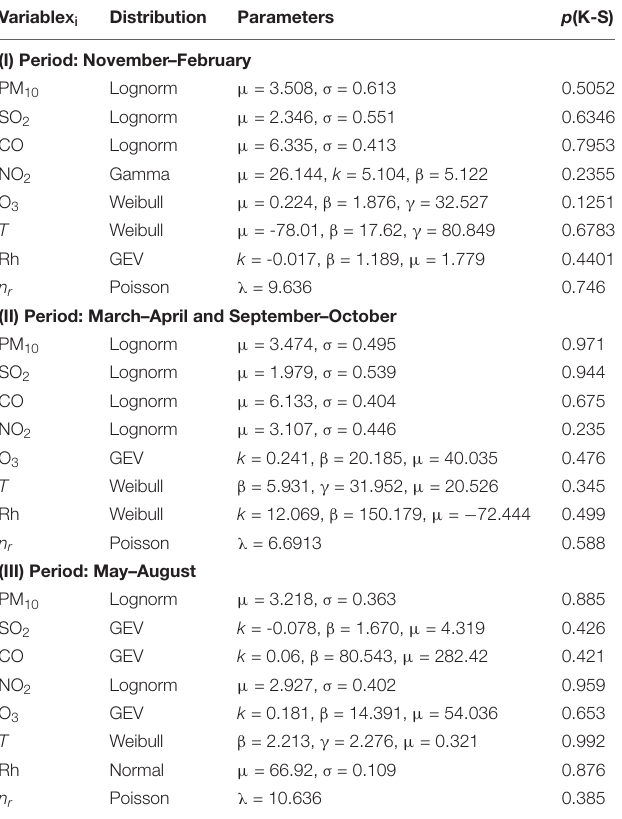
TABLE 1 | Best fit theoretical distributions (according to the Kolmogorov–Smirnov test) for the variables. Variable x i Distribution